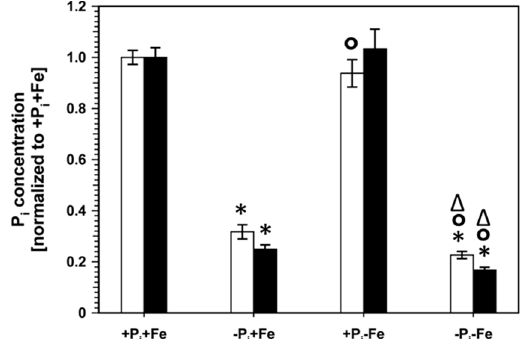
Figure 4. P i concentrations in roots (open bars) and shoots (closed bars) of Col-0 plants. After an initial growth period of five days on nutrient sufficient conditions (+P i +Fe), seedlings were transferred to the indicated conditions and allowed to grow for an additional six days before harvest. +P i :